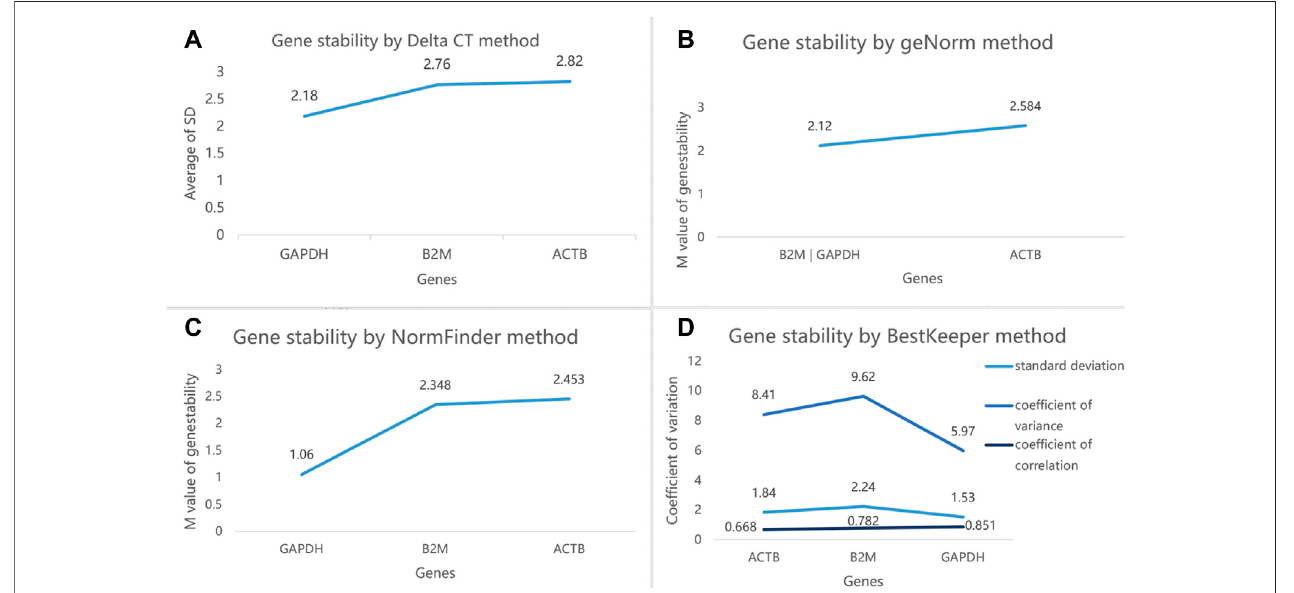
FIGURE 5 | (A) Ranking of the three reference genes based on their expression stability calculated by Delta CT. (B) . GeNorm analysis of the three candidate reference genes. (C) . Stability value of each of the three candidate reference genes from the NormFinder analysis. (D) . BestKeeper algorithm analysis to determine the stability of reference genes, where a low value indicates a more stable expression in the normalization factor. The least stable gene in each step is indicated by arrows.